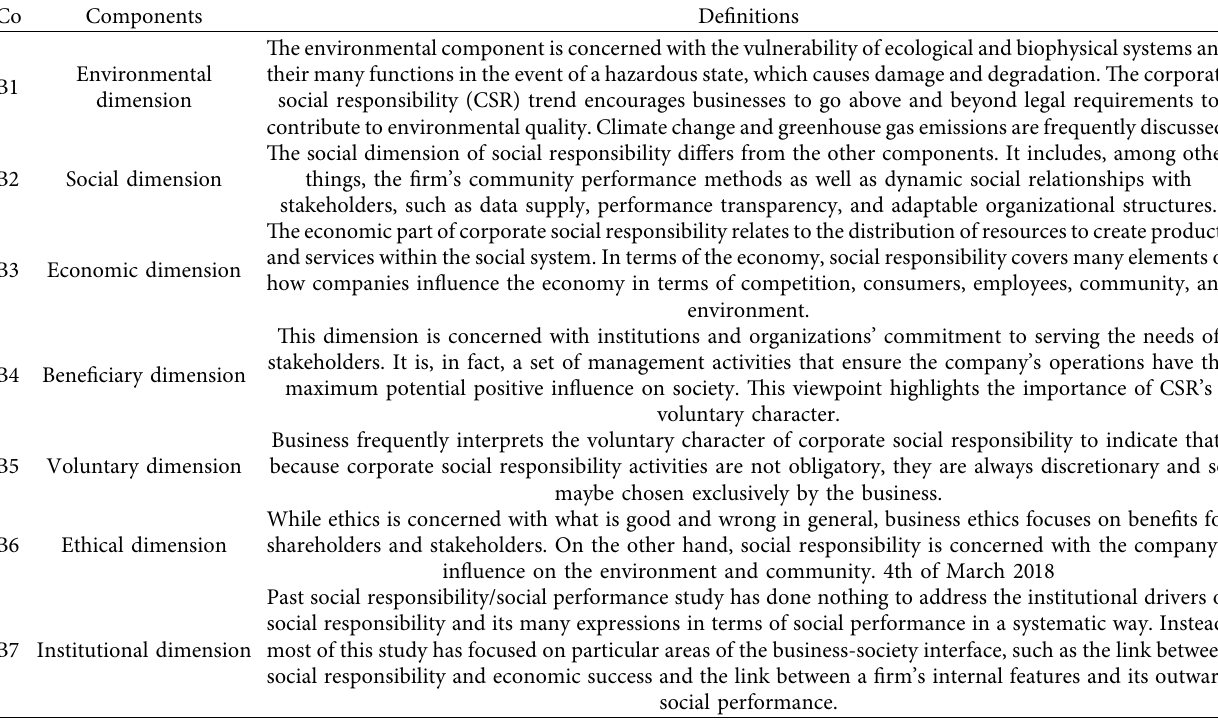
Table 3: Components of social responsibility.